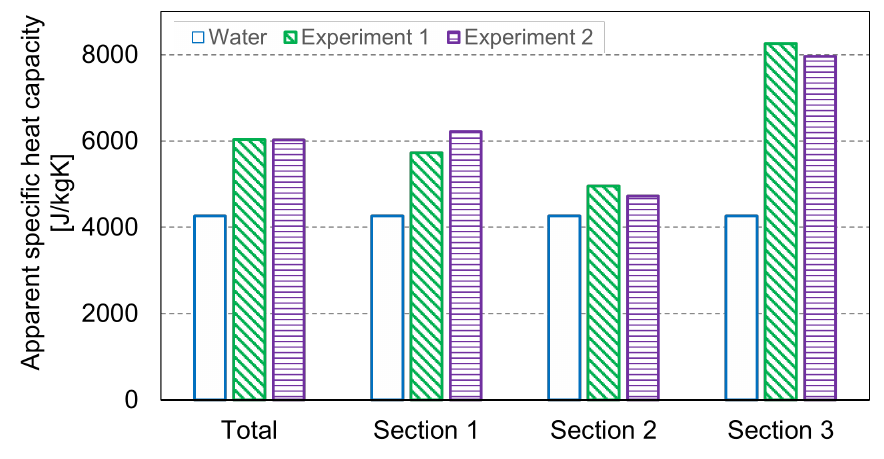
Figure 5. The apparent specific heat capacities calculated for different sections of the tube for the PCD in both experiment 1 and experiment 2. The apparent specific heat capacities of water are also shown.